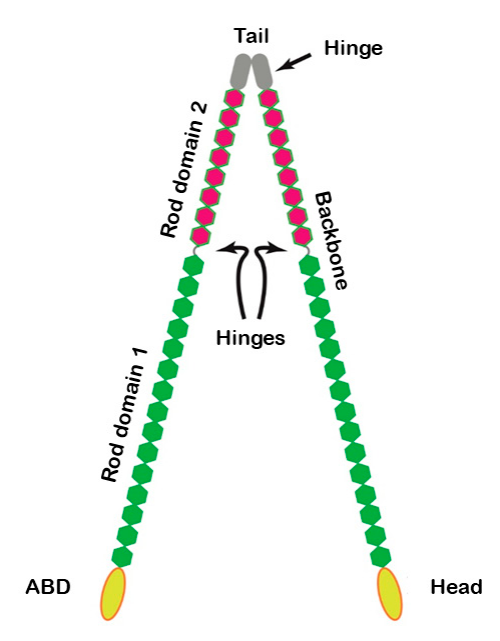
Figure 3. Schematic diagram illustrating the molecular organization of filamin. Relevant regions/domains, included the actin-binding domains (ABD) are highlighted.